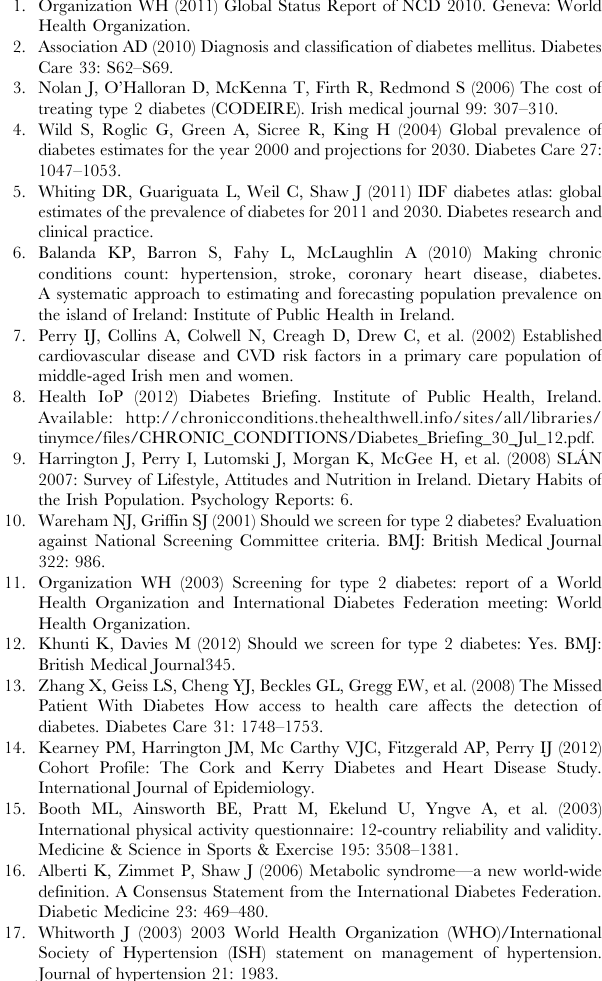
Table S1 Univariate odds ratios (95% CI) of having undiag- nosed or diagnosed type 2 diabetes compared to no diabetes. The table displays univariate associations for socio-economic, meta- bolic and other health related variables with either undiagnosed or diagnosed diabetes. Diagnosed subjects were excluded from models examining undiagnosed diabetes. Undiagnosed subjects were excluded from models examining diagnosed